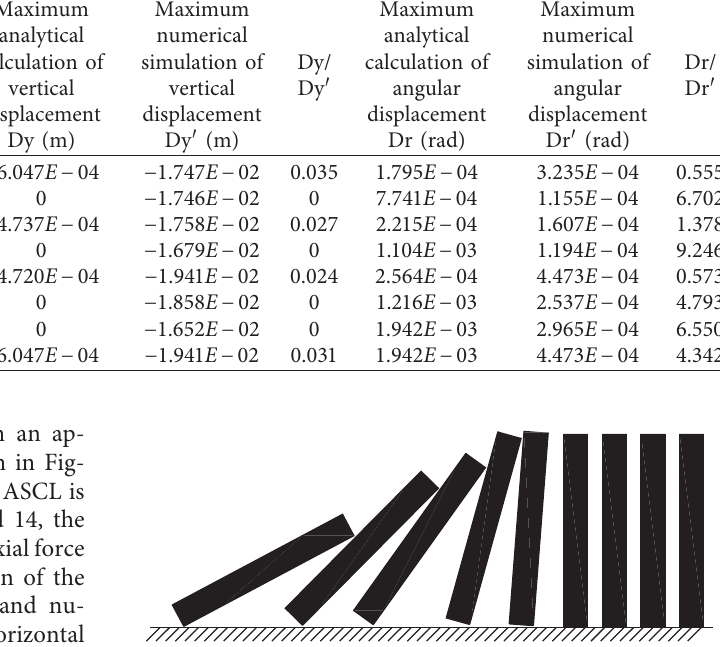
Figure 13: The domino effect. The domino effect occurs when several dominoes are arranged in rows according to certain spacing; when the first domino is pushed over, the other dominoes behind it will be pushed over in a chain reaction.